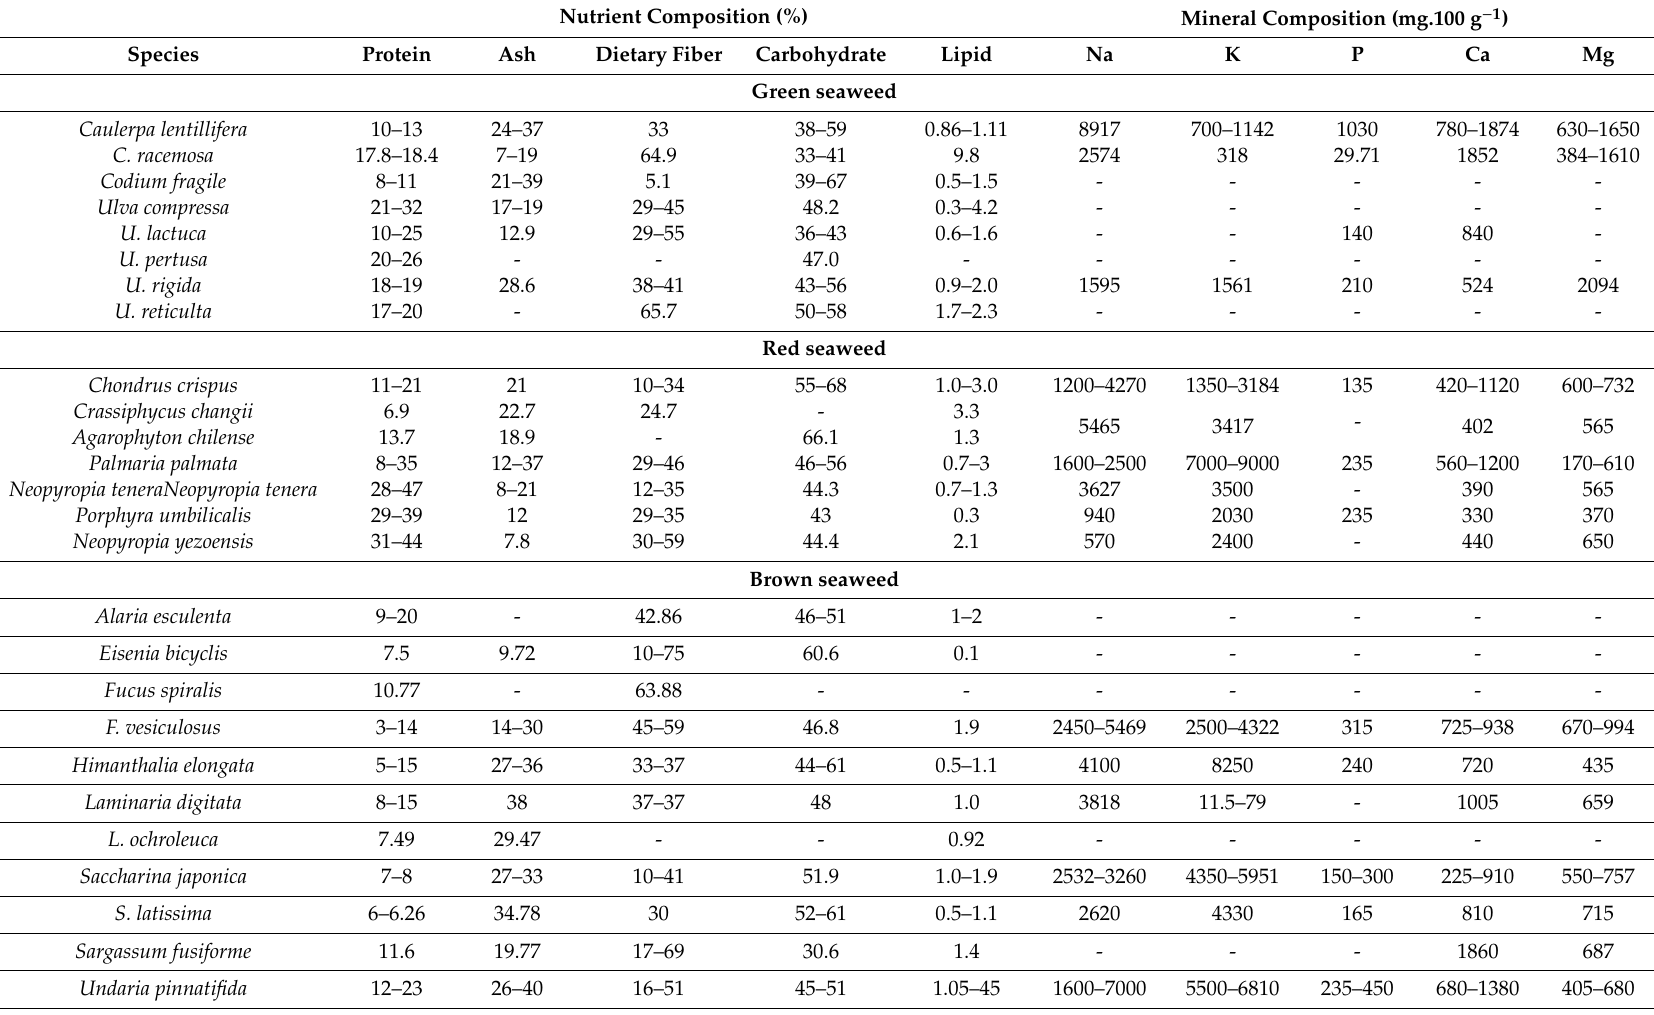
Table 1. Nutrient (% dry weight) and mineral (mg 100 g − 1 dry weight) composition of some edible seaweeds